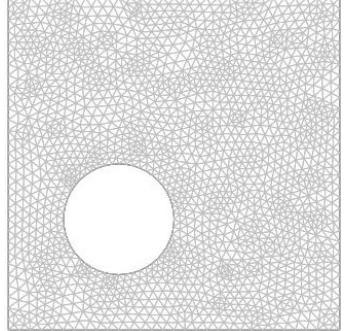
Figure 3. Mesh configuration for the cavity.